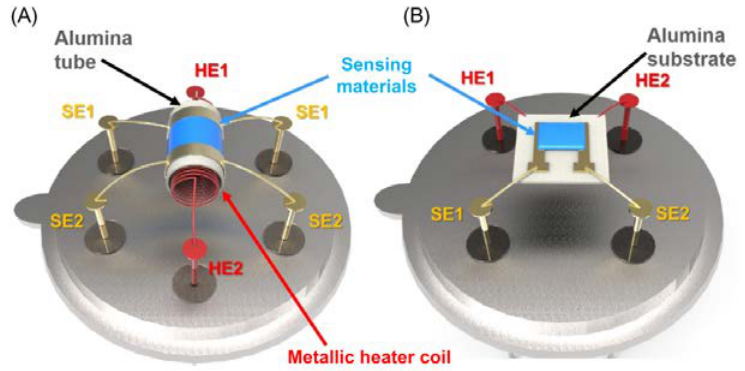
Figure 3. Schematic structure of ( A ) tube-type and ( B ) substrate-type oxide semiconductor gas sensors (SE, sensor electrode; HE, heater electrode). Reprinted with permission from Ref. [39]. Copyright 2019, Lee, J.-H.